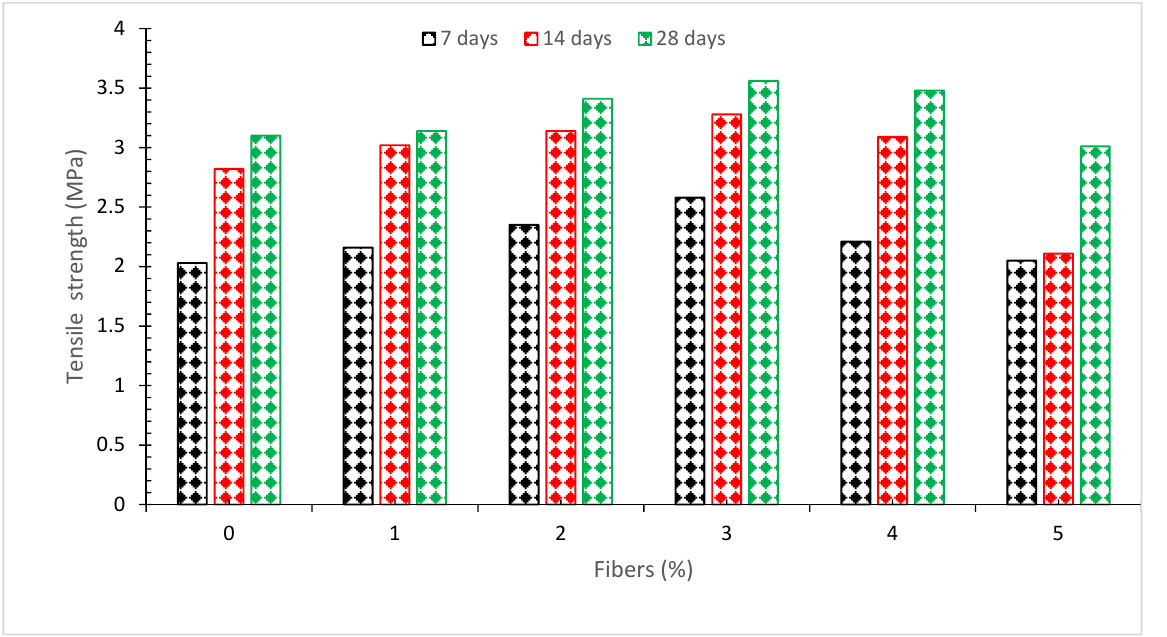
Figure 6. Tensile strength [24].